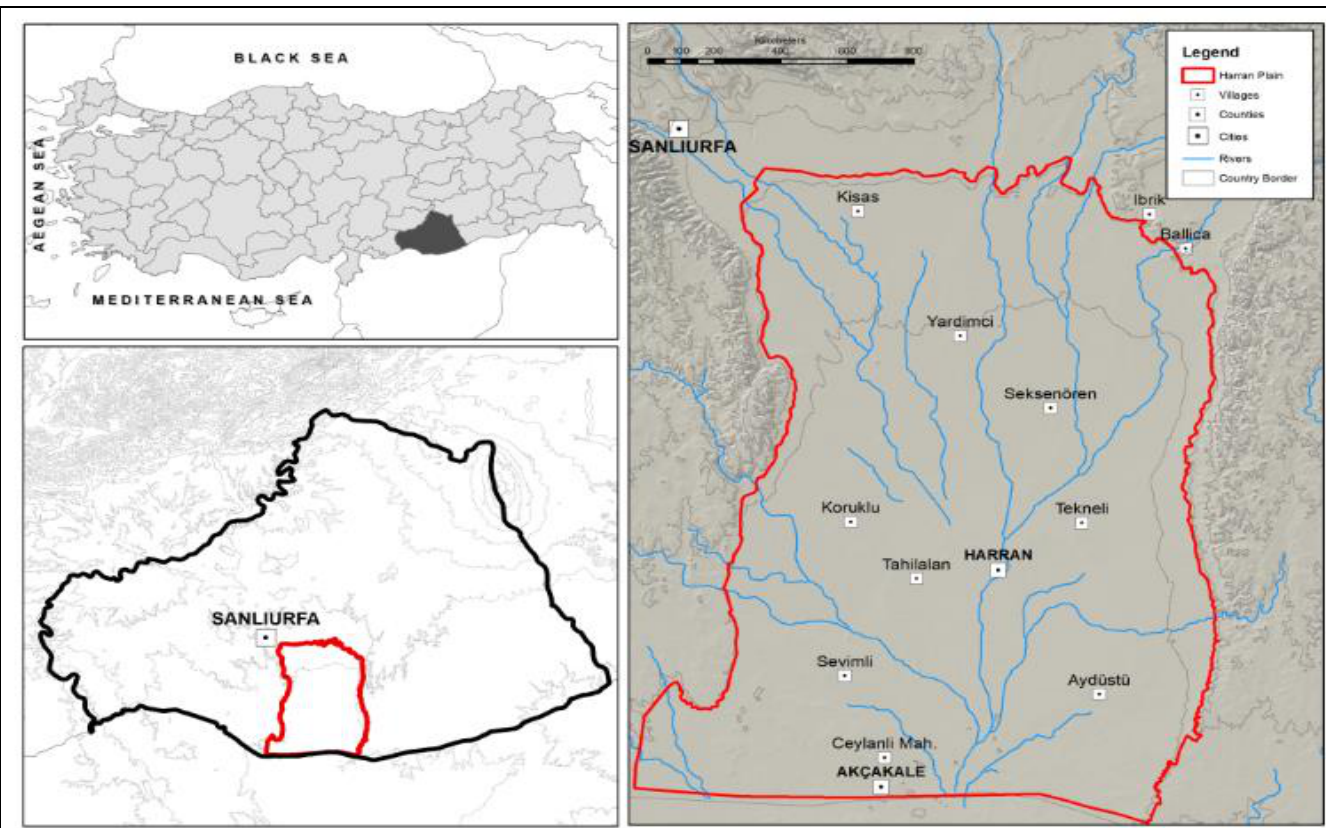
Figure 1: The location of Harran Plain.